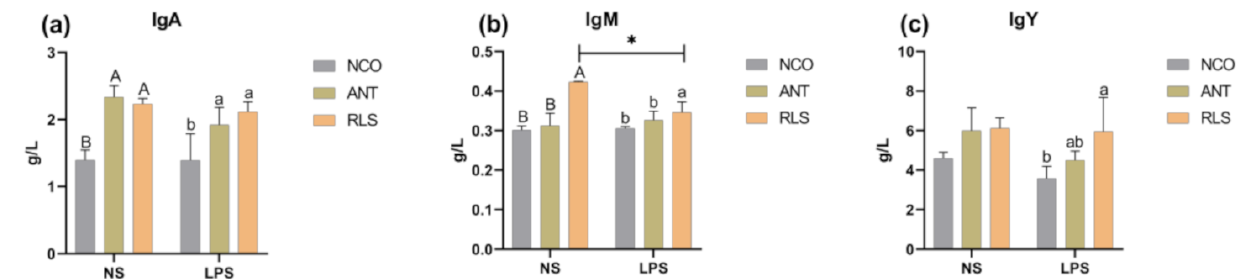
Figure 2. Effects of RLS on immunoglobulins in broilers challenged with LPS. ( a ) Effect of RLS on IgA. ( b ) Effect of RLS on IgM. ( c ) Effect of RLS on IgY. NS-NCO represents control broilers treated with normal saline; NS-ANT represents broilers treated with the antibiotic; NS-RLS represents broilers treated with rhamnolipids; LPS-NCO represents control broilers challenged with LPS; LPS-ANT represents broilers treated with the antibiotic and challenged with LPS; LPS-RLS represents broilers treated with rhamnolipids and challenged with LPS; * and different superscript letters indicate significant differences ( p < 0.05), majuscule present NS-groups and lowercase present LPS-groups, n =